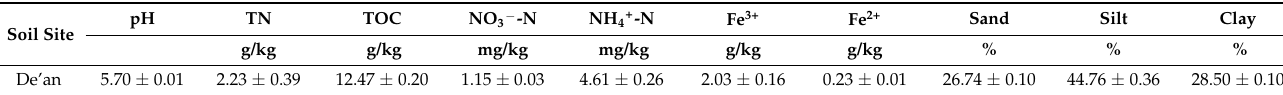
Table 1. The chemical and physical properties of the soil used.